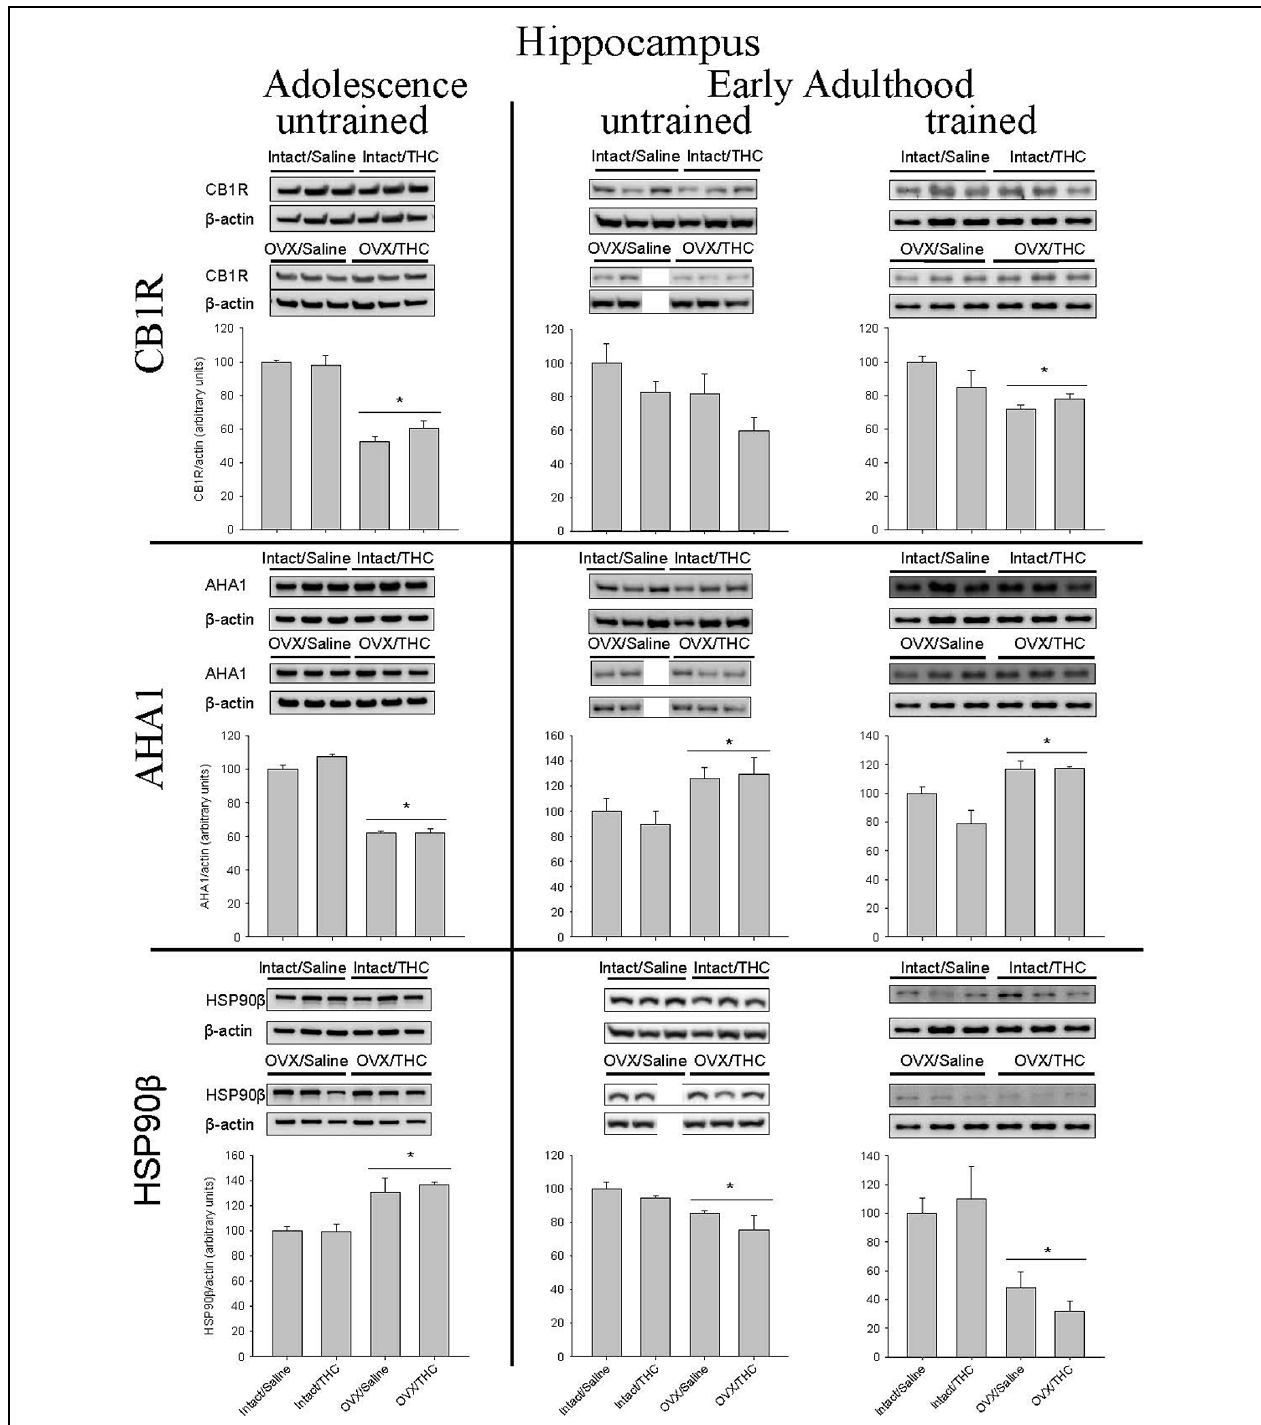
FIGURE 6 | Effects of chronic (cid:2) 9 -THC and hormone status on the endogenous levels of CB1R, AHA1, and HSP90 β in the hippocampus. Above each bar graph are western blots of protein levels in hippocampal extracts from the female rats in each of the four chronically treated groups. The extracts were separated by 10% SDS-PAGE, transferred onto PDVF membranes, and subjected to western blotting with specific antibodies for each protein. The data were quantified